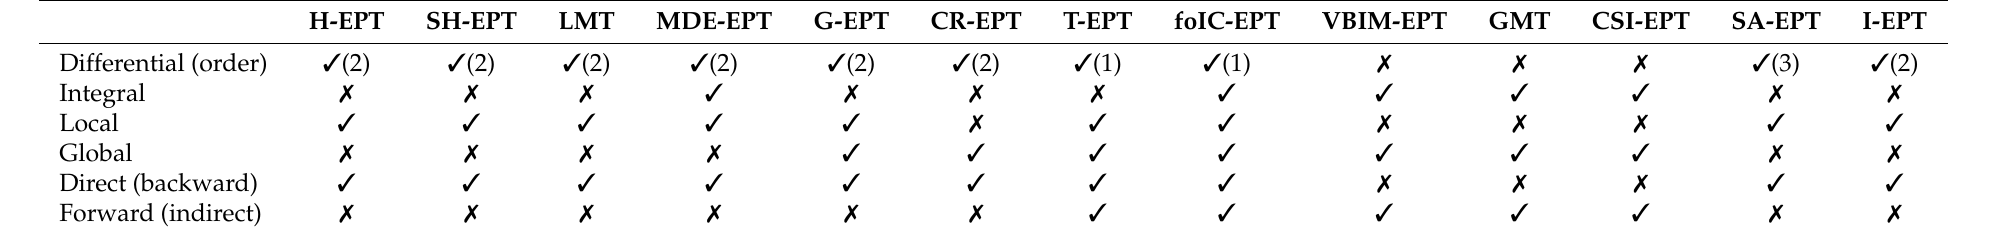
Table 1. Approach description for the EPT approaches as described in this manuscript.